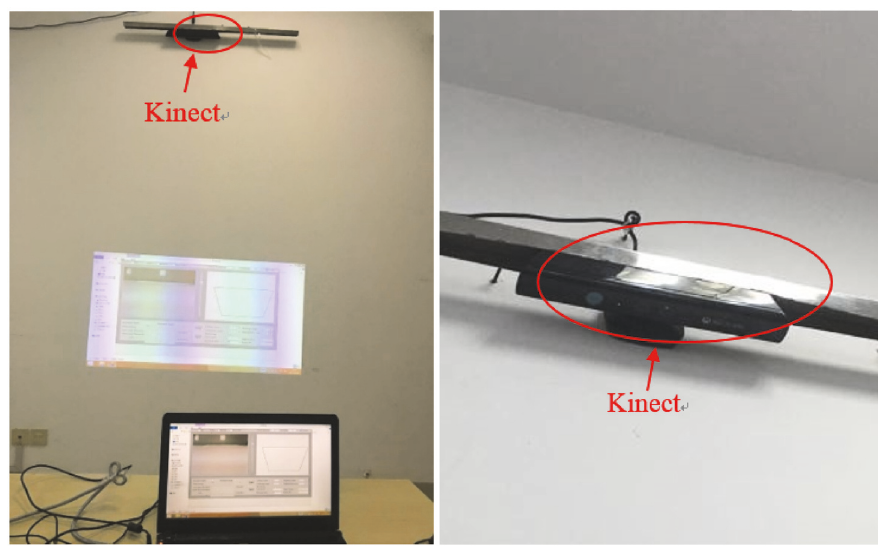
Figure 2: The self-developed human-computer interactive positioning software platform.